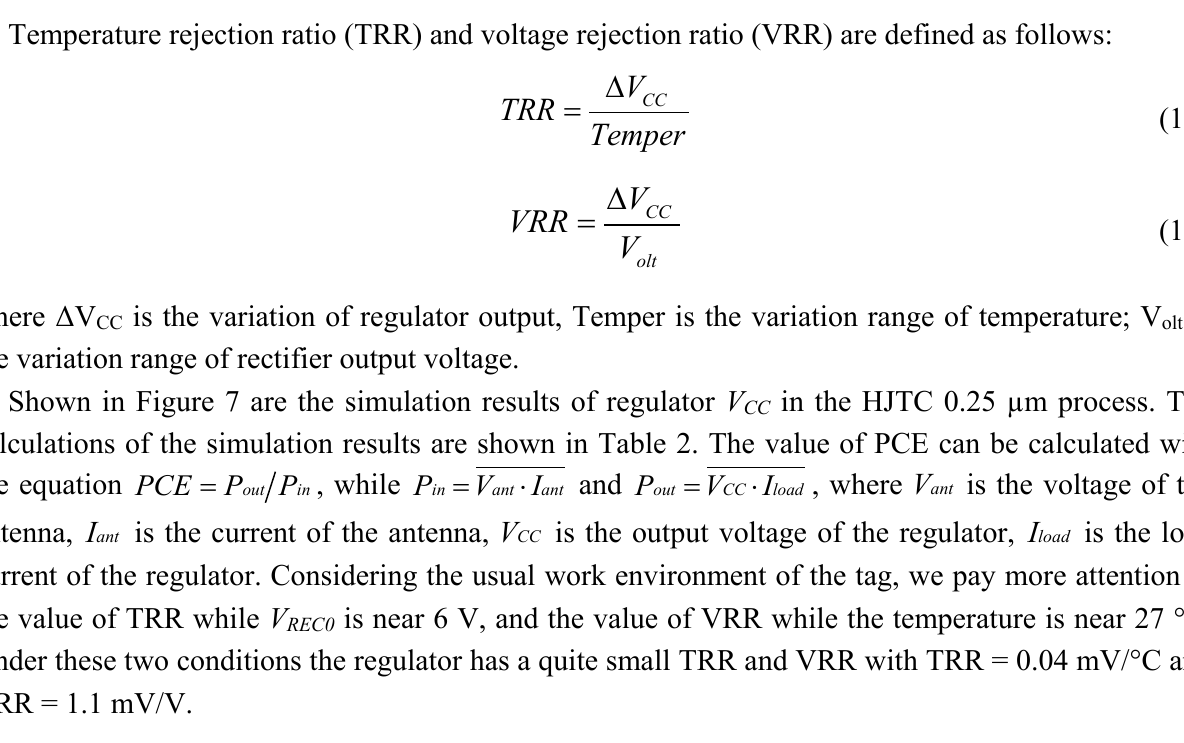
, V = 6V; ( b ) V CC REC0